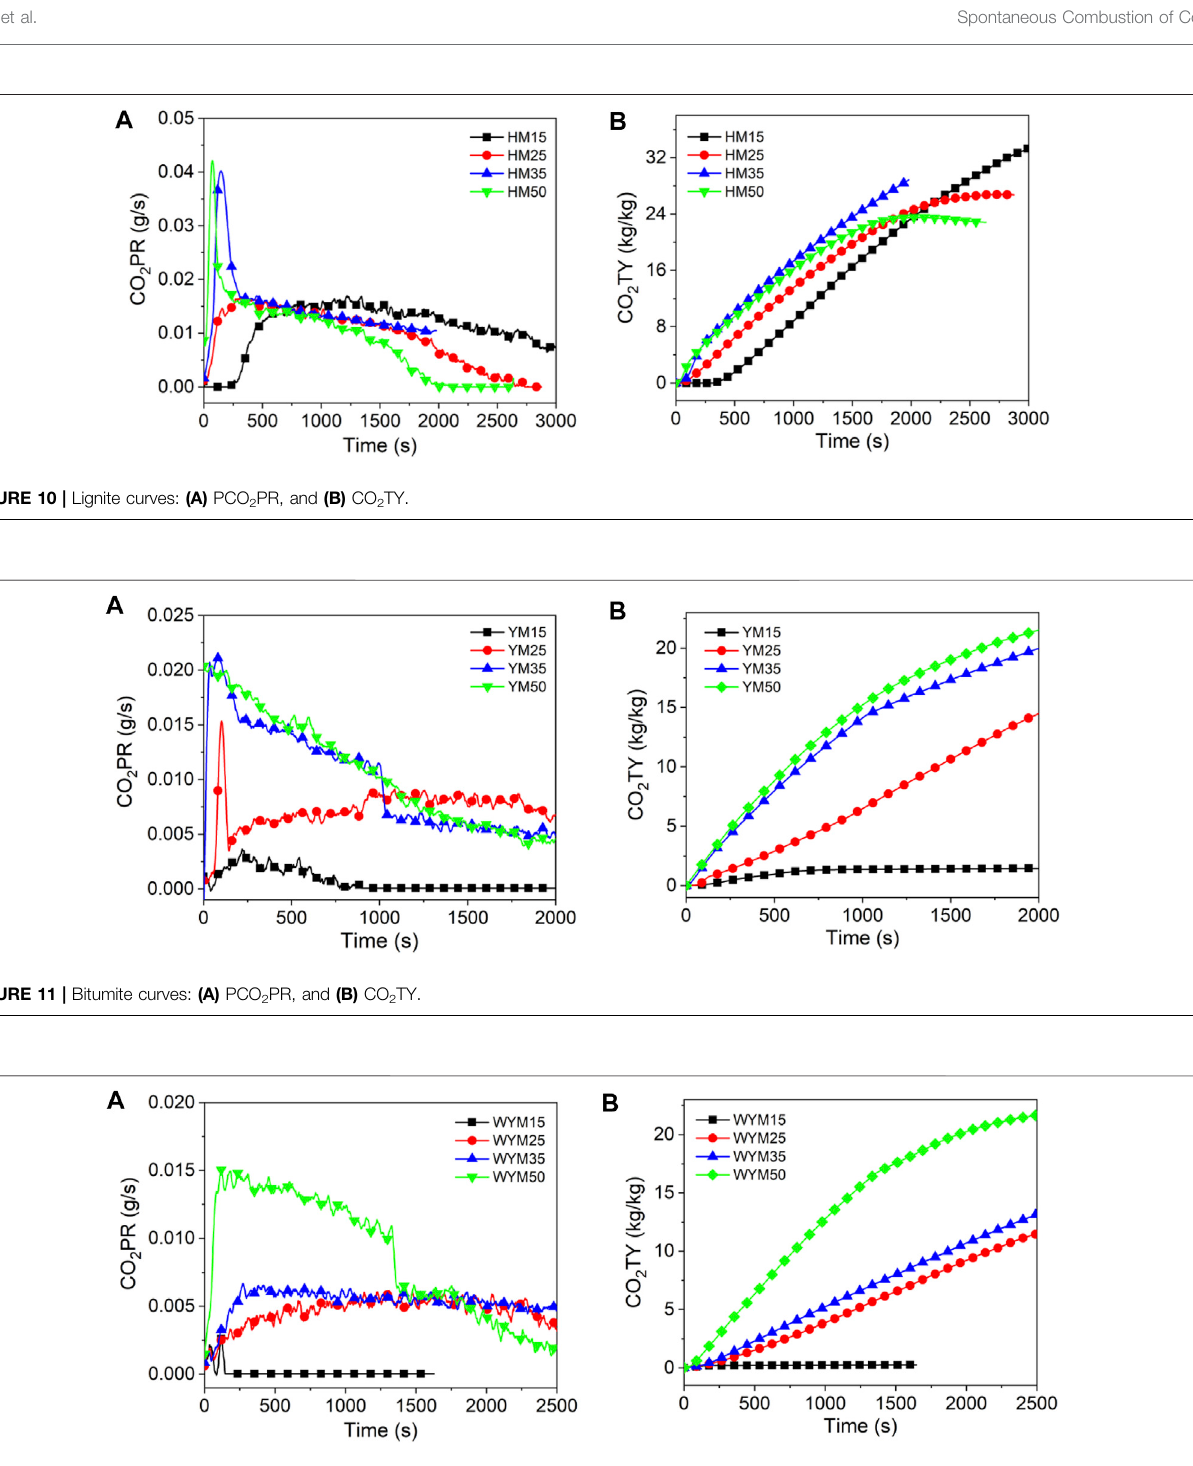
Frontiers in Materials |